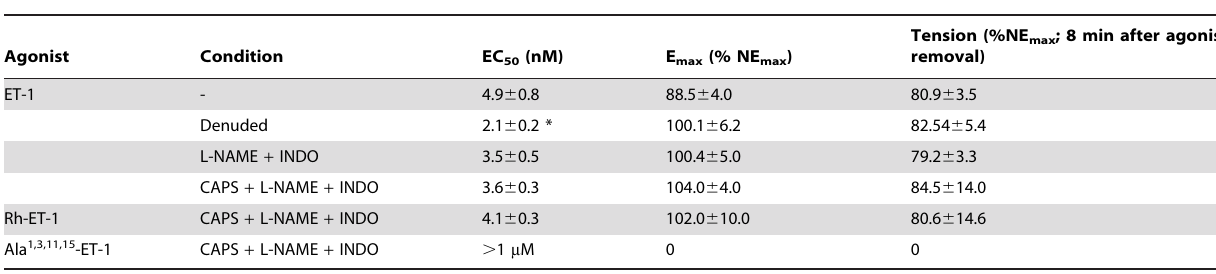
Table 1. Arterial effects of ET-1 and two analogues.